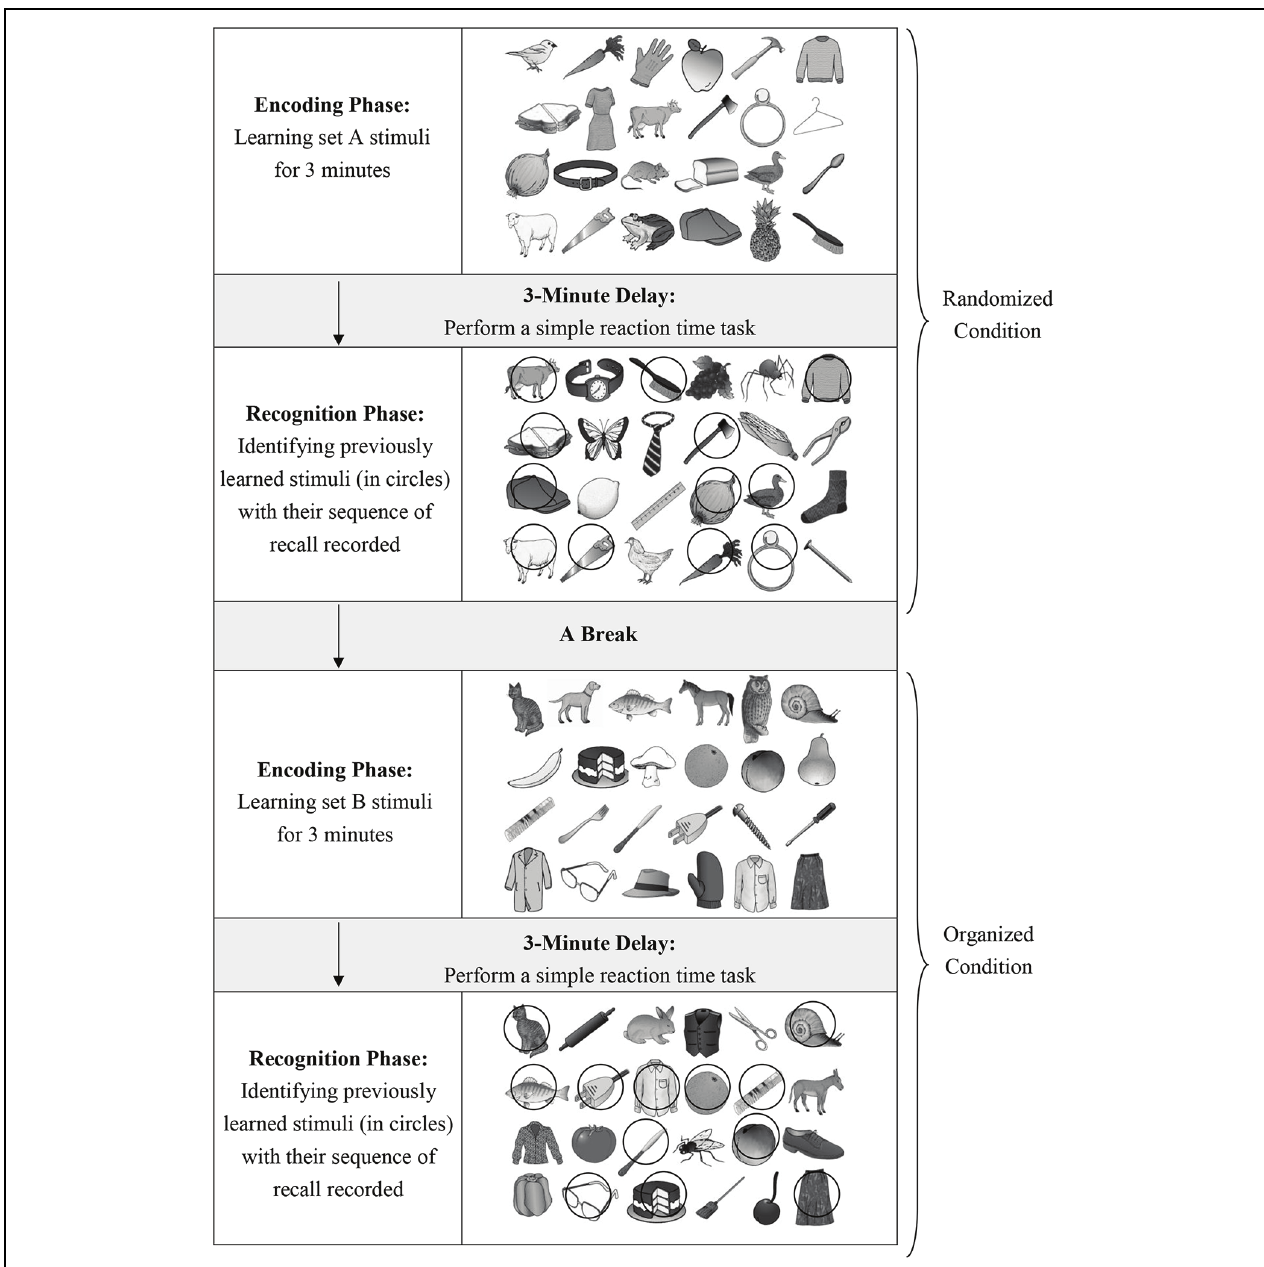
FIGURE 1 | An illustration of the experimental paradigm of the visual memory task.